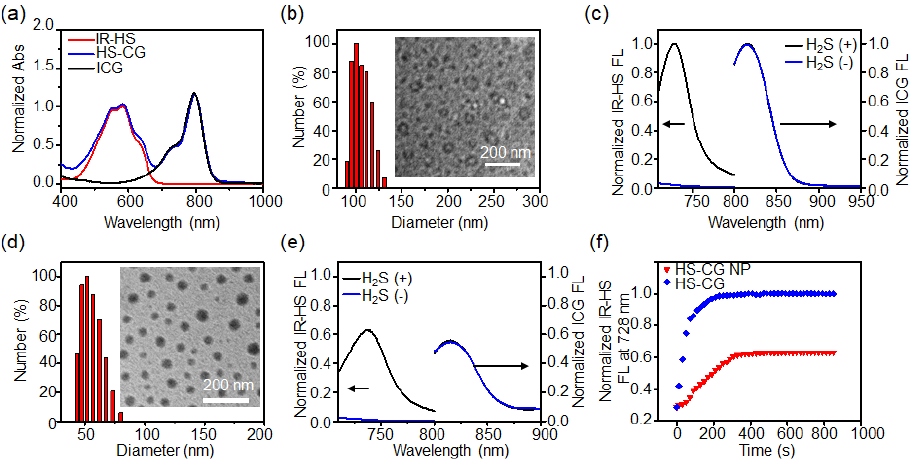
Figure 2. Characterization of HS-CG in vitro. ( a ) UV – Vis – NIR absorption spectra of HS-CG, IR-HS, and ICG NPs in PBS buffer. ( b ) Dynamic light scattering (DLS) analysis and transmission electron microscopy (TEM) image (inset) of HS-CG. ( c ) Fluorescence spectra of HS-CG before ( − ) and after (+) reaction with NaHS (500 μ M) for 30 min. ( d ) DLS analysis and TEM image (inset) of HS-CG NP,